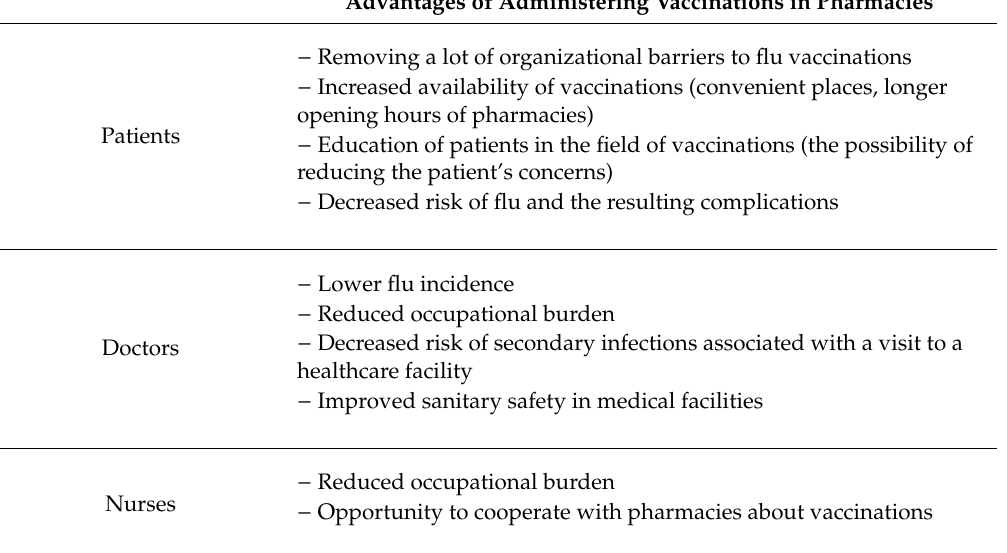
Table 2. Advantages of administering vaccinations in pharmacies for patients, medical sta ff and the healthcare